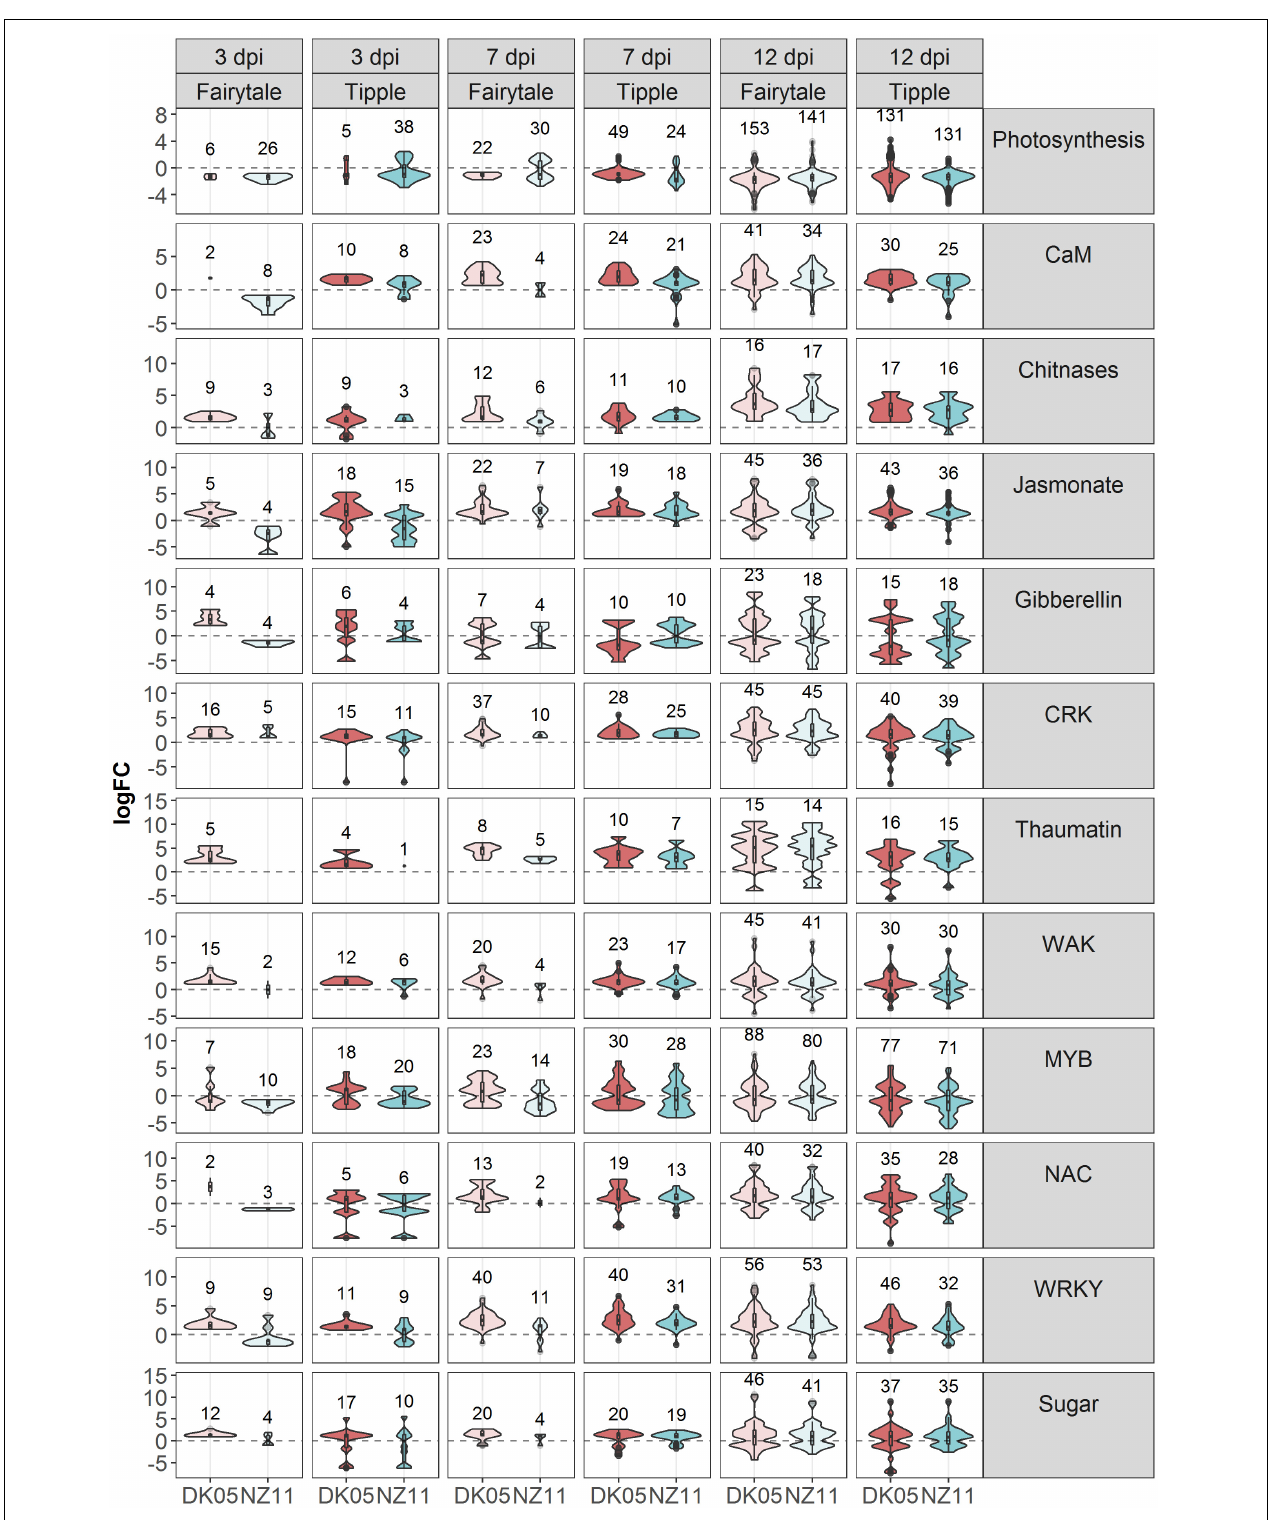
FIGURE 4 | V| iolin plots depicting differentially expressed (DEG) barley genes on sub-categories of molecular gene functions affected by Rcc colonization and disease progression. Violin plots with included box-whisker plots depicting the general trend of up and down regulation during RLS progression on barley ( Hordeum vulgare L ) cv Fairytale and cv Tipple during foliar infection with Rcc isolates DK05 and NZ11.